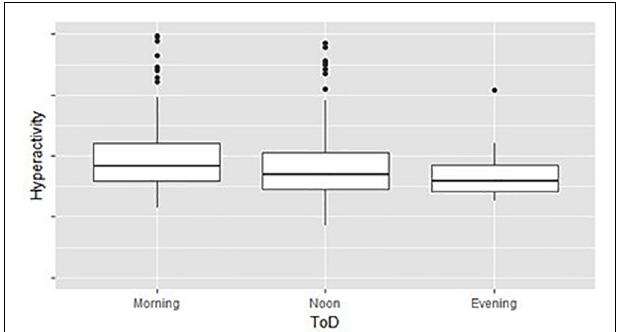
FIGURE 2 | Hyperactivity as a function of time of day (ToD) in children without attention-deficit/hyperactivity disorder (ADHD) group differences are significant ( F = 8.26, p <